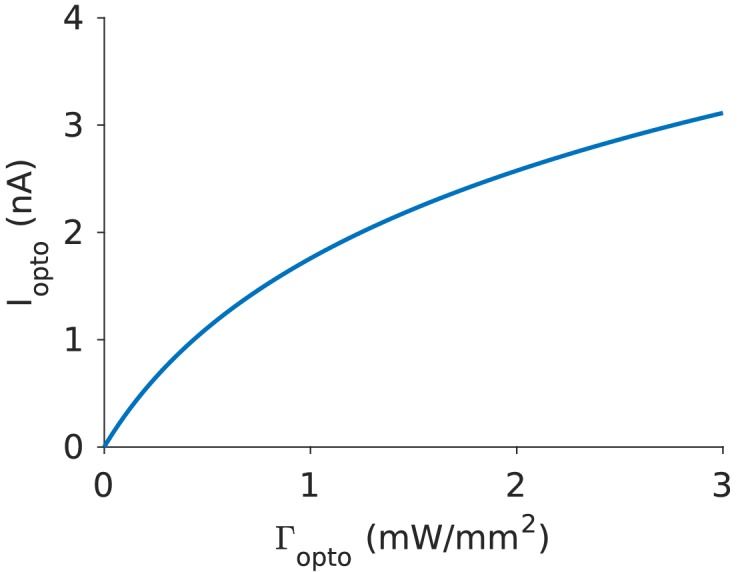
Current, Iopto, v.s. laser intensity, Γopto.Parameters are I0=8nA, Γ0=0.5mW.mm−2.